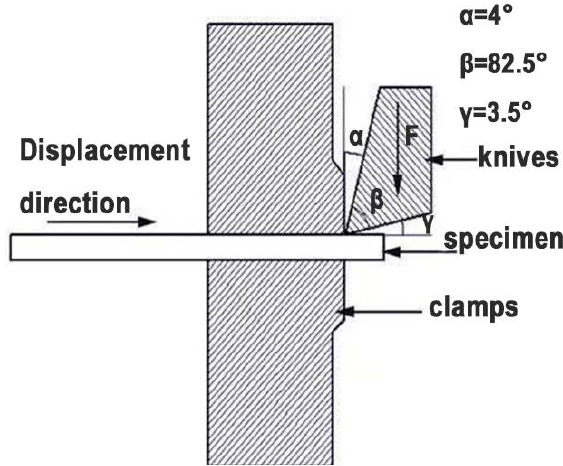
Figure 2. Schematic diagram of the microshear.